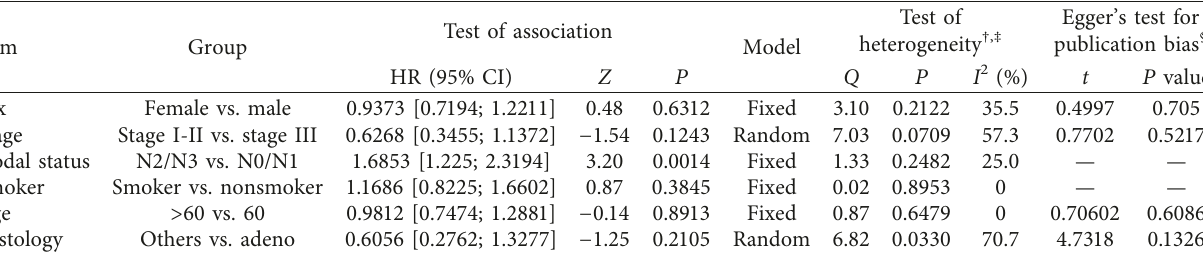
Table 2: Fixed/random effects for oligometastatic non-small-cell lung cancer of overall